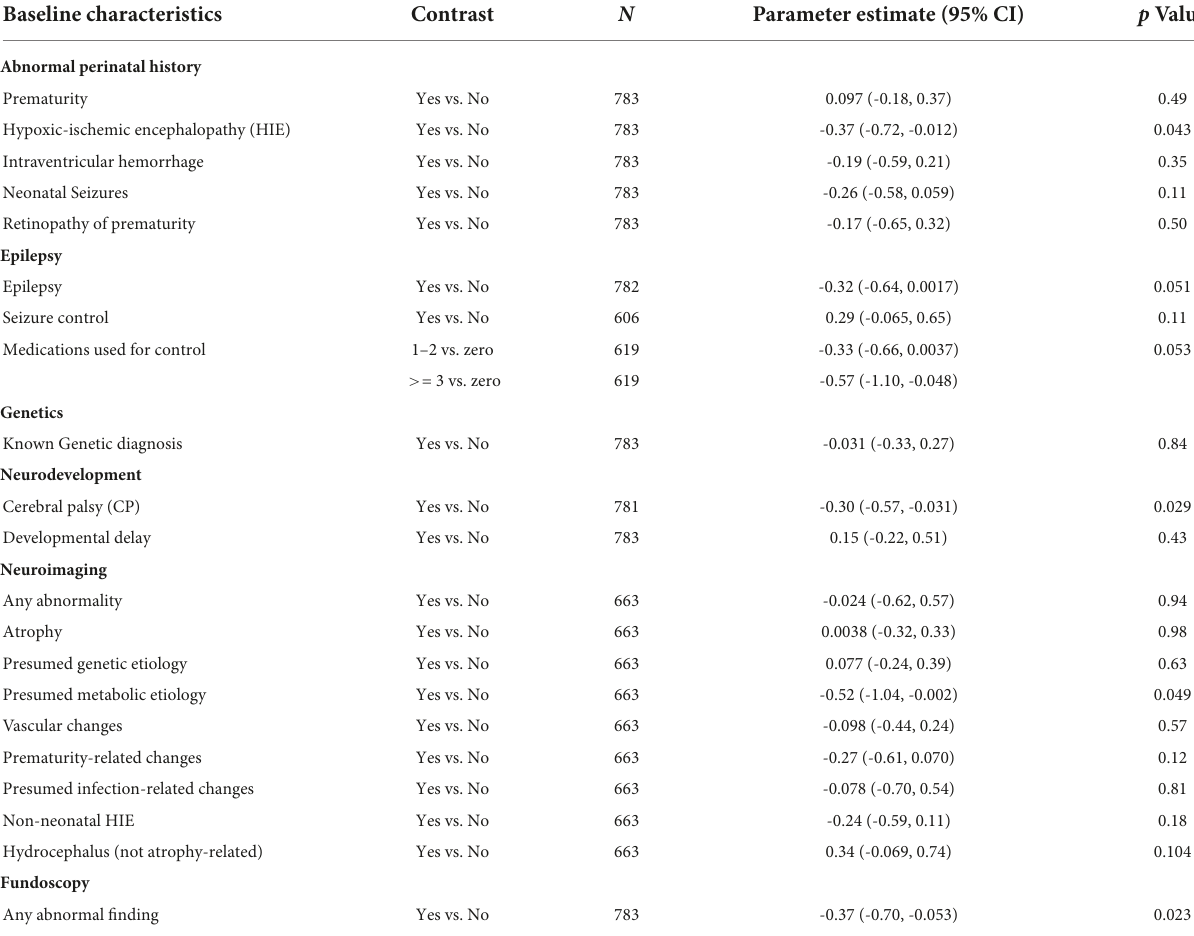
TABLE 4 Effect of individual baseline characteristics on longitudinal CVI grade outcome using mixed-effect models. Baseline